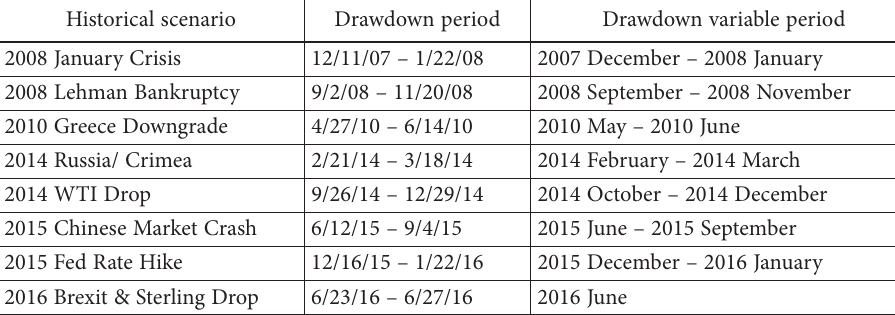
Table 6. Global Hedge Fund Industry Drawdown